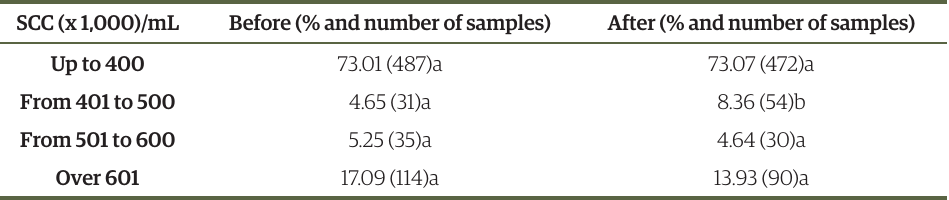
table 1. Somatic Cell Count (SCC) of total amount of milk of 106 herds in Alagoas, before and after application of Good Manufacturing Practices to milking from November, 2010 to May,